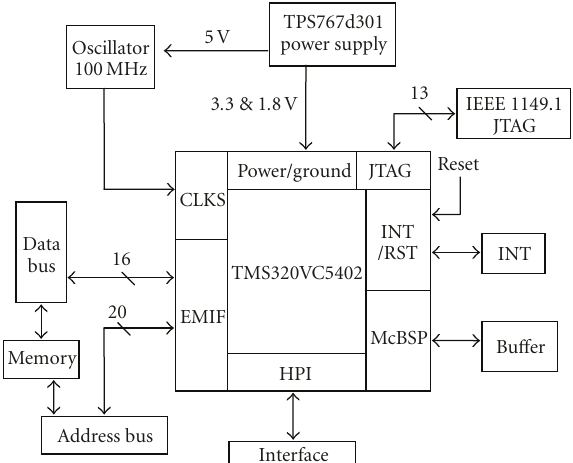
Figure 2: Functional blocks of the self-developed DSP platform.